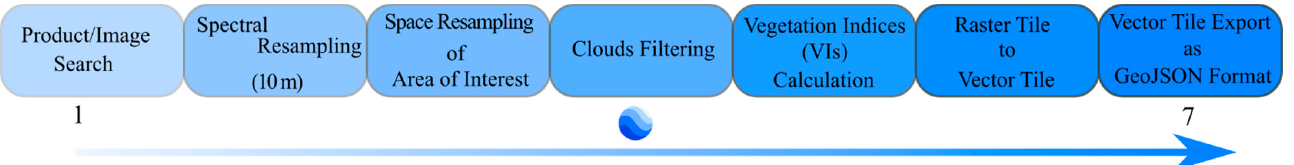
Figure 2. A stepwise illustration (1 to 7) of processing and downloading satellite imagery products from Google Earth Engine (GEE).